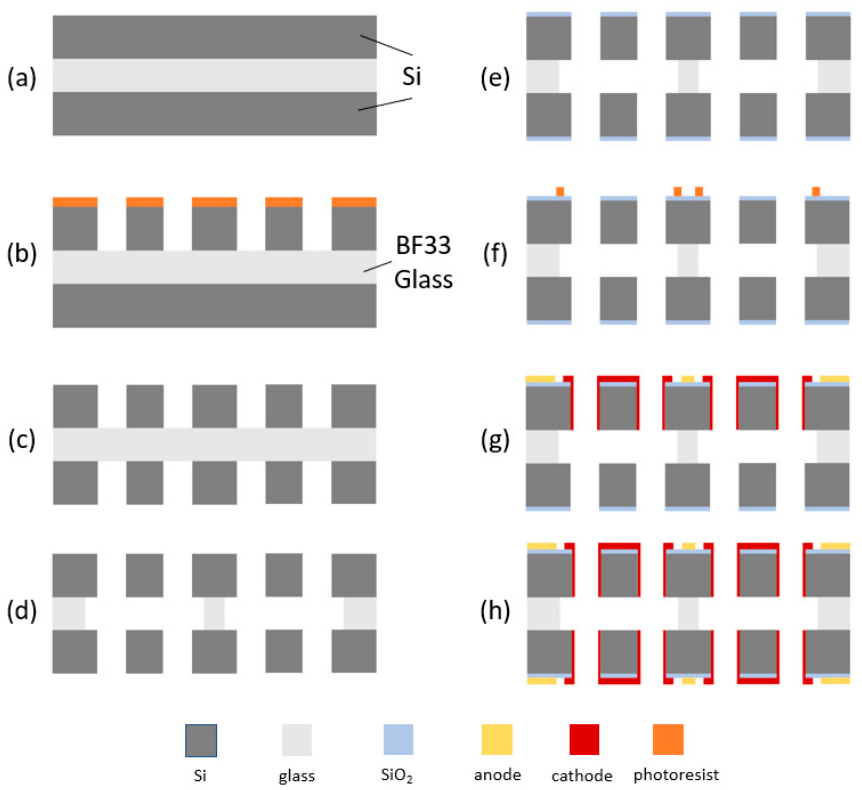
Figure 4. The fabrication processes of the sensing unit with four layers of electrodes integrated on one silicon–glass–silicon bonded wafer: ( a ) preparation of silicon–glass–silicon bonded wafer, ( b ) lithography and deep reactive ion etching (DRIE) on one side, ( c ) lithography and DRIE on the other side, ( d ) etching the glass layer to form flow holes, ( e ) chemical vapor deposition (CVD) SiO 2 on both sides, ( f ) lithography on one side, ( g ) sputtering and patterning anode and cathode and ( h ) lithography, sputtering and patterning anode and cathode on the other side.